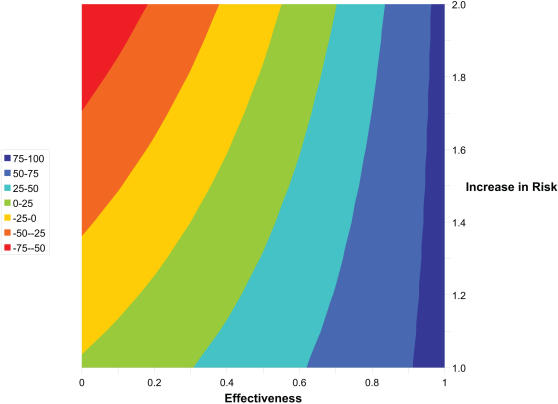
Contour Graph for Decline in Cumulative Infections (%) as a Function of Effectiveness of PrEP and Increase in Risk Behavior Assuming Optimistic Scenario.Negative numbers reflect increase in infections.